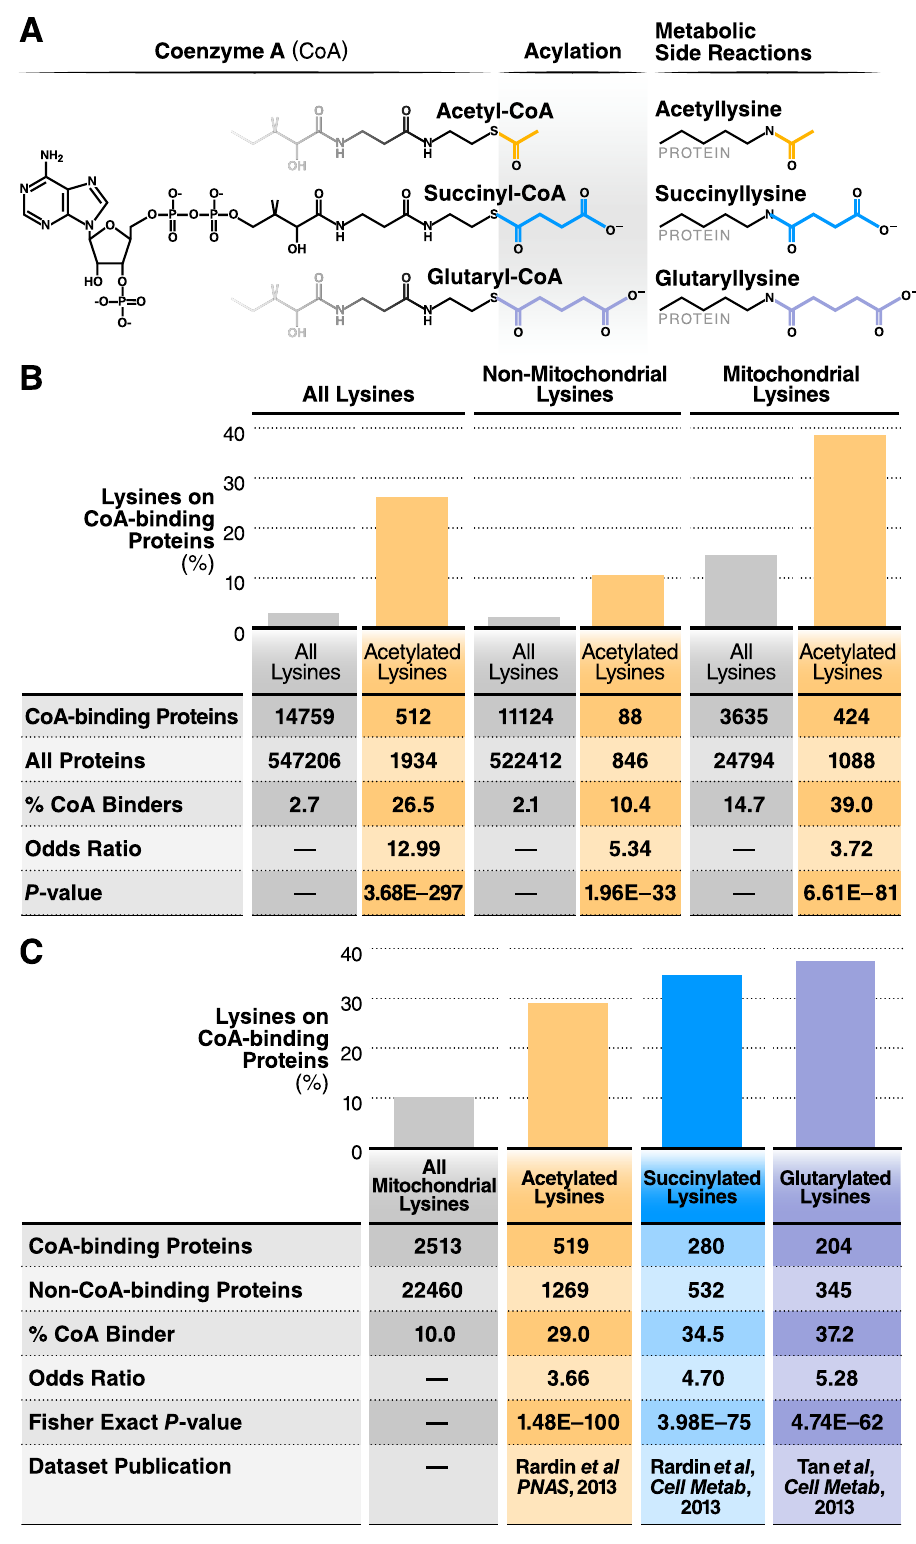
Figure 2. Lysine acylation is significantly over-represented on CoA-binding proteins. ( a ) Diagram of acetylation, succinylation, glutarylation modifications to protein lysine residues. ( b ) Table showing the enrichment of acetylated lysines on CoA-binding proteins analyzed in a whole-cell mouse liver acetylome dataset. This enrichment is also present when the dataset was separated into non-mitochondrial and mitochondria lysines. Significance was calculated using Fisher’s exact test. ( c ) Table showing the enrichment of acetylated, succinylated, and glutarylated lysines on CoA-binding proteins, using mitochondrial mouse liver datasets. For ( b ) and ( c ), statistical significances were calculated using Fisher’s exact